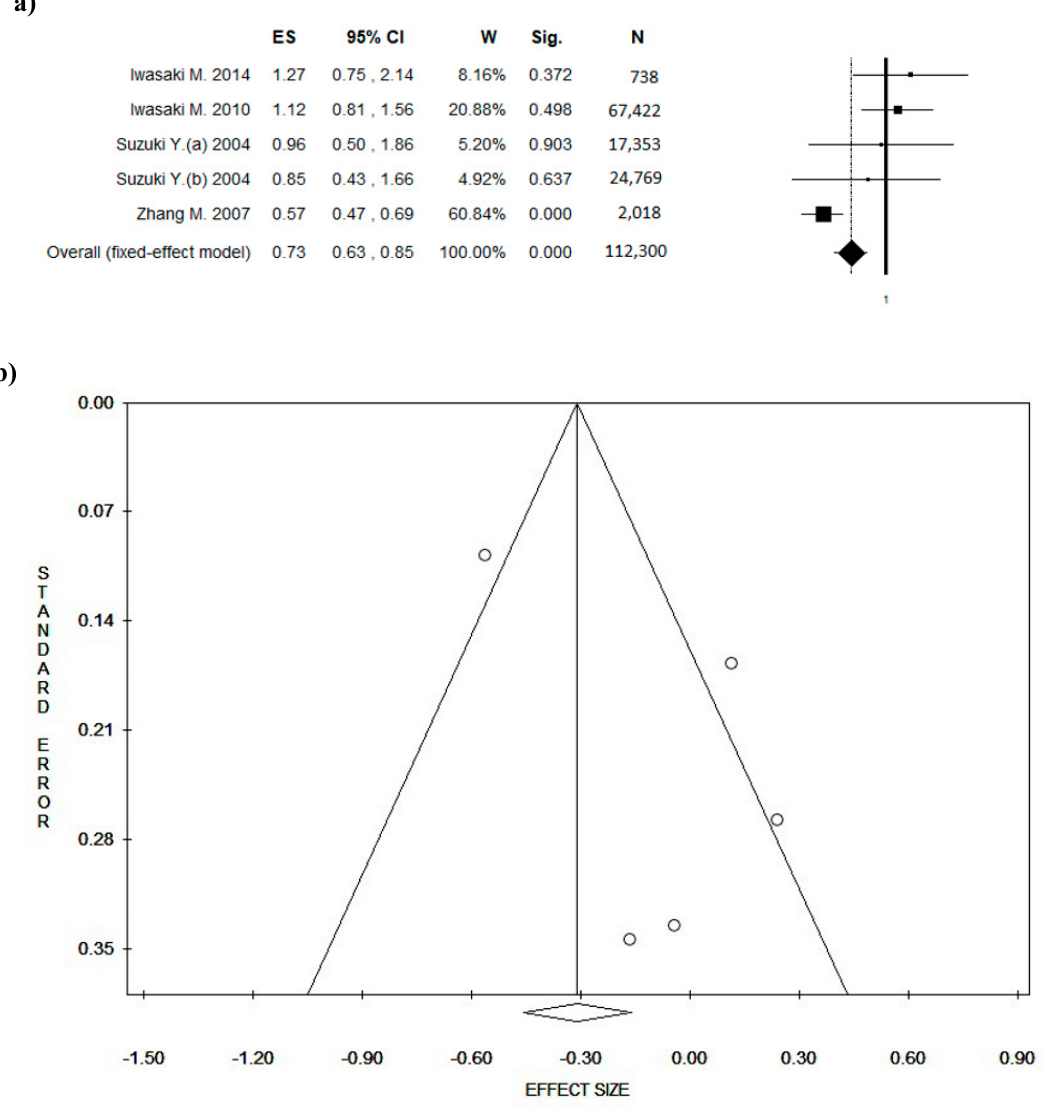
Figure 5. Forest plot ( a ) of the meta-analysis comparing green tea consumption in breast cancer (BC) (studies with quality score ≥ 5). Funnel plot ( b ). Abbreviations: ES = effect size; CI = confidence interval; W = weight; Sig = significance; N = number.